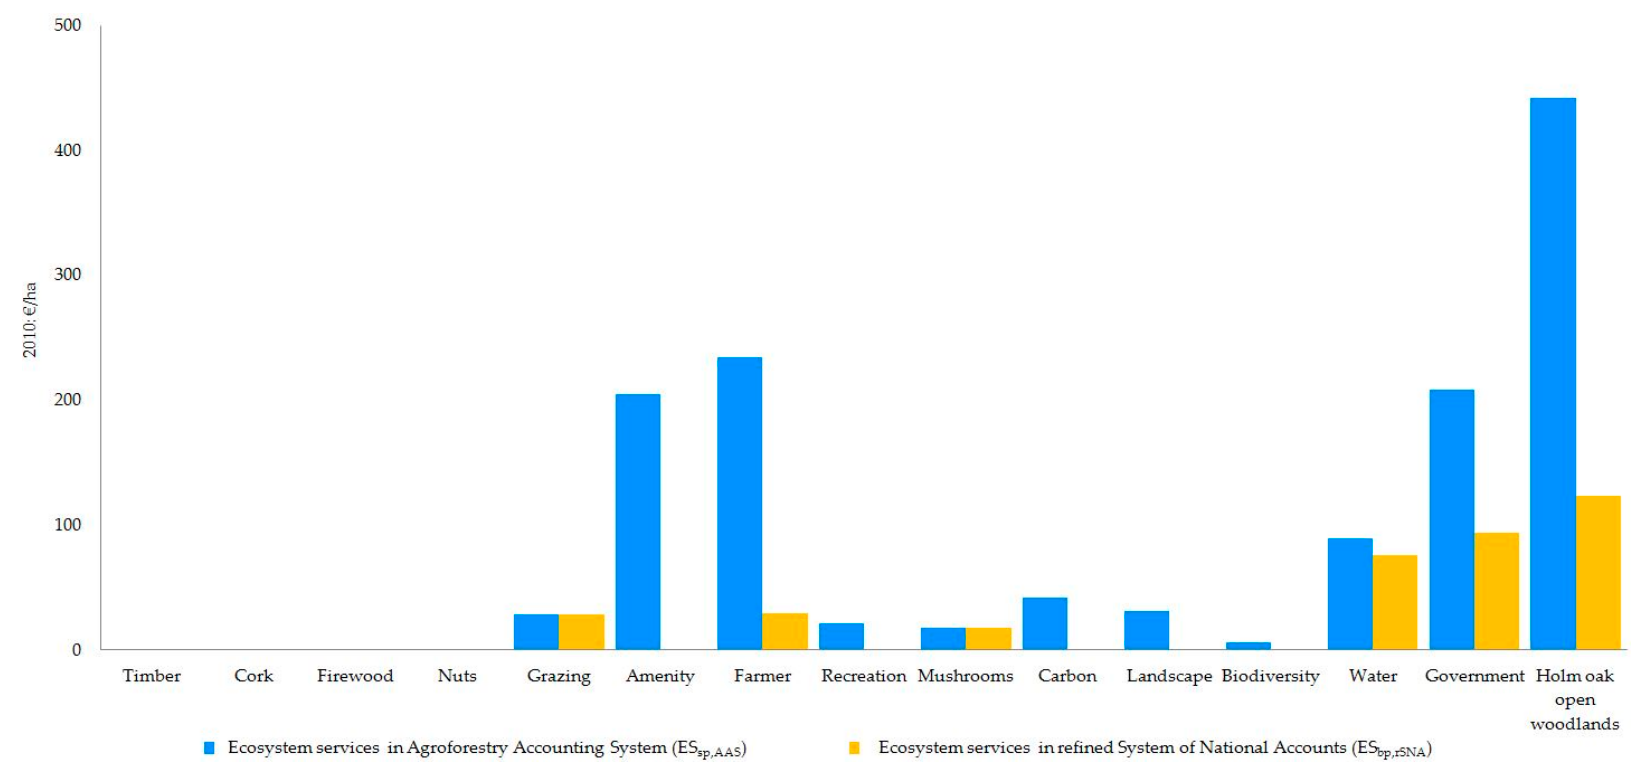
Figure 8. AAS and rSNA ecosystem services at social and basic prices comparison for holm oak open woodlands in Andalusia (2010: €/ha).